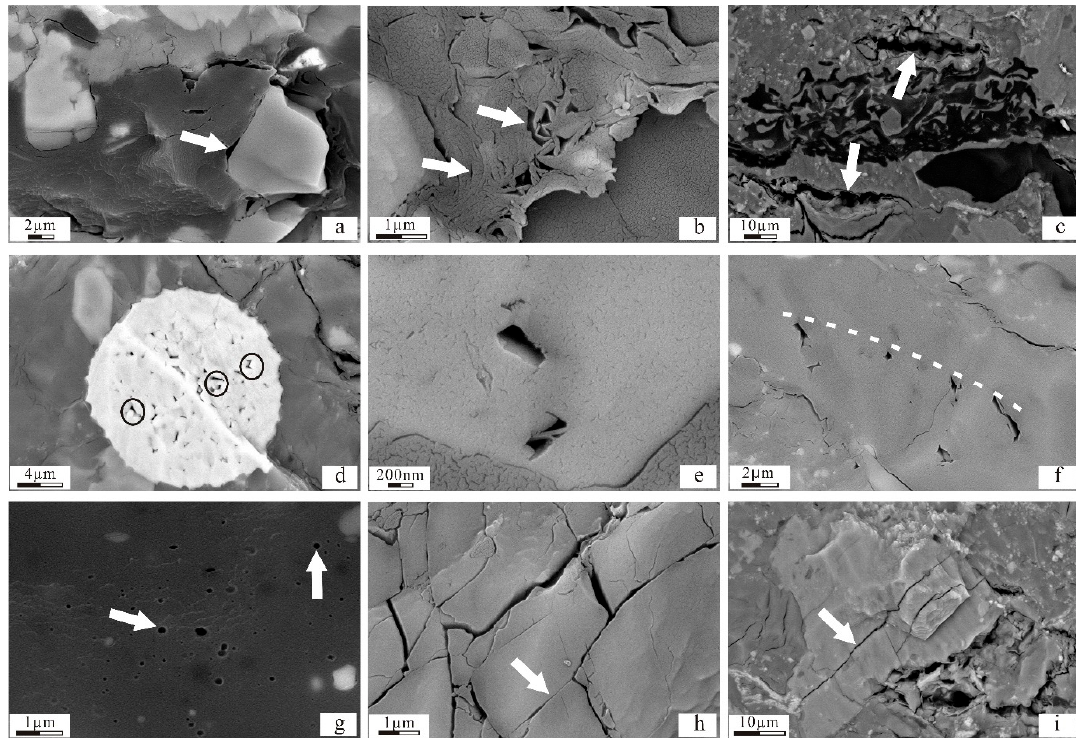
Figure 1. FE-SEM images of shale samples from the Laochang area, eastern Yunnan, China. ( a ) intergranular pores, at the margins of rigid partials and organic matter, S1 well, 746.8 m; ( b ) intergranular pores, between flexural deformed clay minerals, S2 well, 653.6 m; ( c ) dissolved pores, at the edge of particles, S2 well, 662.0 m; ( d ) intragranular pores, inside strawberry-like pyrite, S2 well, 662.0 m; ( e ) intragranular defect pores, within ankerite, S2 well, 653.6 m; ( f ) intragranular defect pores within ankerite distribute in band, S1 well, 823.7 m; ( g ) gas pores, inside the organic matter, S1 well, 789.2 m; ( h ) cleavage, inside the ankerite, S2 well, 653.6 m; and ( i ) fractures inside the feldspar, S2 well, 662.0 m.).